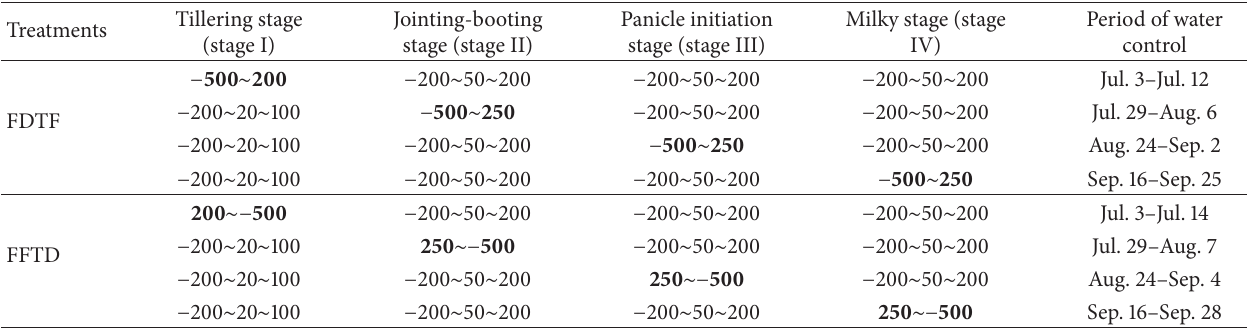
Table 1: Controlled thresholds in different stages for controlled irrigation and drainage (CID) in the year 2015.